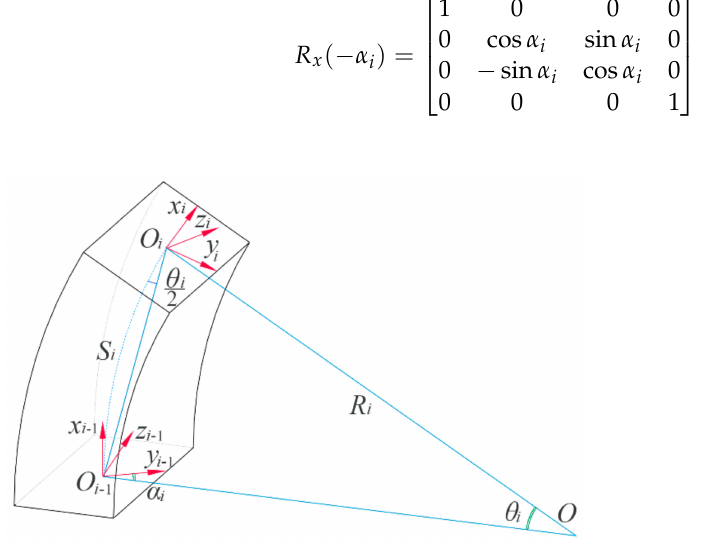
Figure 6. A schematic diagram for the coordinate transformation between two